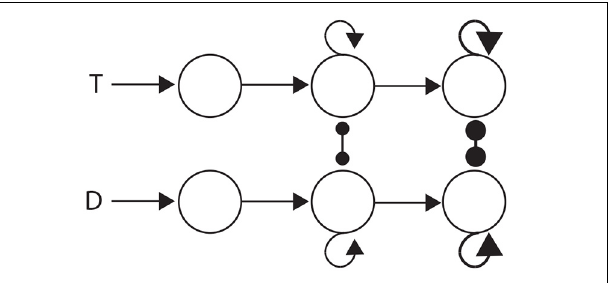
FIGURE 4 | Three processing stages for decisions: the encoding of evidence (left), the integration of encoded evidence (middle) and choice selection (right). Evidence-encoding populations (left) are responsive to target (T) and distractor (D) stimuli. Weak dynamics prevent integration, depicted by the lack of recurrent connectivity. Evidence-encoding populations project to integrator populations (middle) . Feedback connectivity depicts moderately strong dynamics, suitable for temporal integration (corresponding to Figure 3 ). Integrator populations project to thresholding circuitry (right) . Thick connectivity depicts very strong dynamics, suitable to an all-or none response to a critical level of input (see Simen,